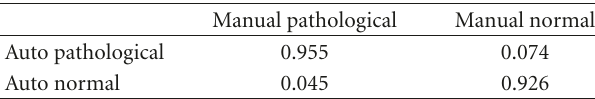
Table 5: Mean confusion matrix for the 10 test sets (One correlation case).